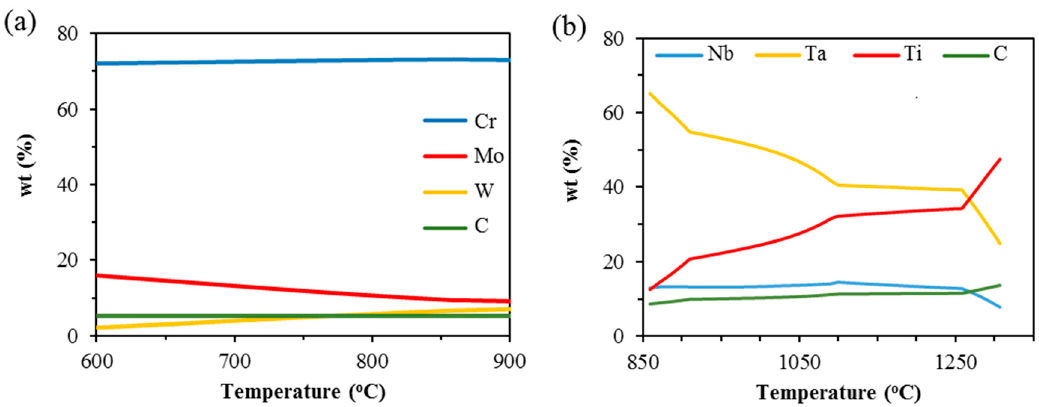
Figure 4. Changes in the chemical composition of carbides at different temperatures: ( a ) M 23 C 6 and ( b ) MC.